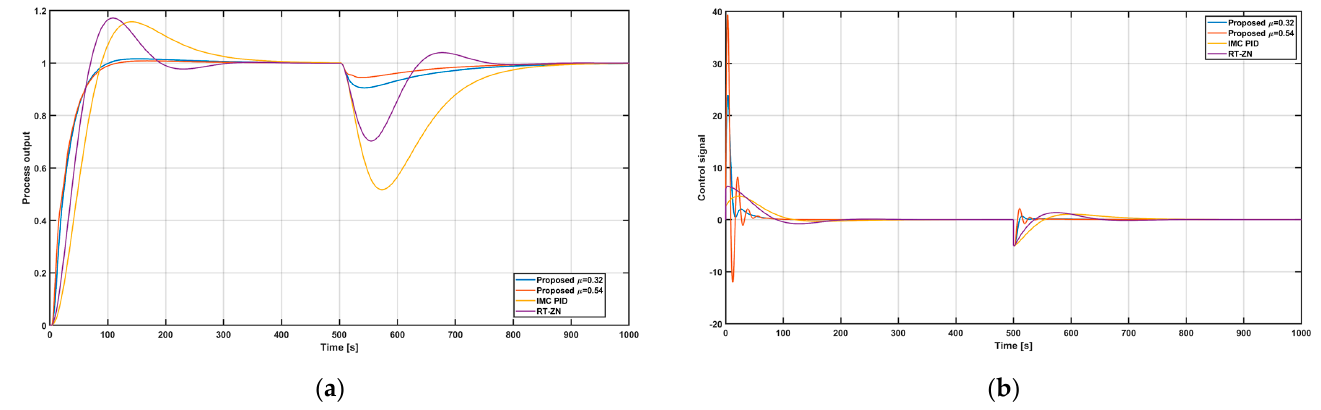
Figure 8. Comparison of PID controllers: proposed “robust” PID for µ = 0.32 (blue), proposed “performance” PID for µ = 0.54 (blue), IMC PID (violet), and RT-ZN PID (yellow). ( a ) Process output, ( b ) control